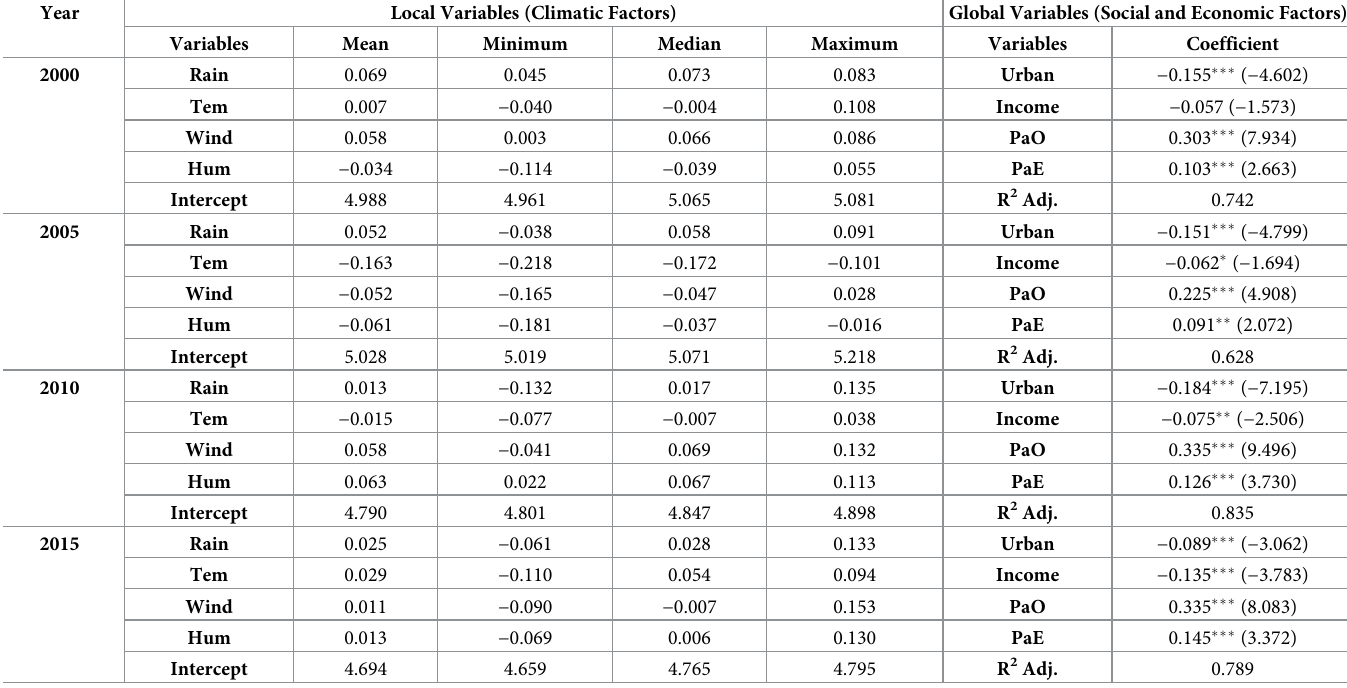
Table 5. Estimation results of MGWR